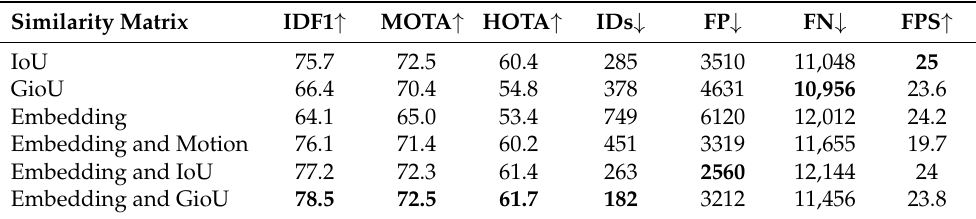
Table 4. Data association comparison of different similarity matrices. The best results are shown in bold